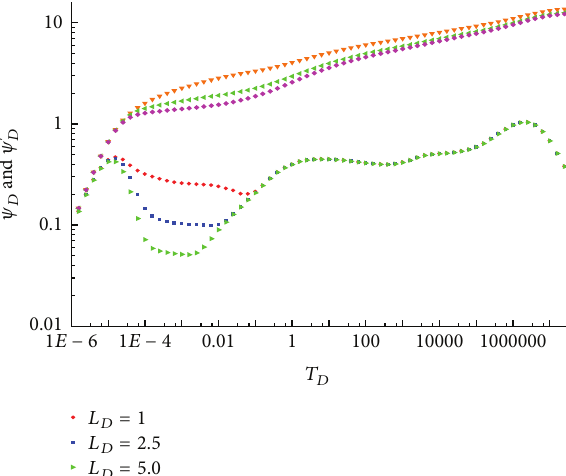
Figure 11: Influence of 𝐿 𝐷 on the bottom-hole pressure with mixed boundary ( 𝜔 = 0.01 , 𝜆 = 300 , 𝛽 = 50 , 𝑍 𝑤𝑑 = 0.5 , 𝐶 𝑑 = 0.0001 , 𝑠 = 1 , and 𝑟 𝑒𝐷 = 50